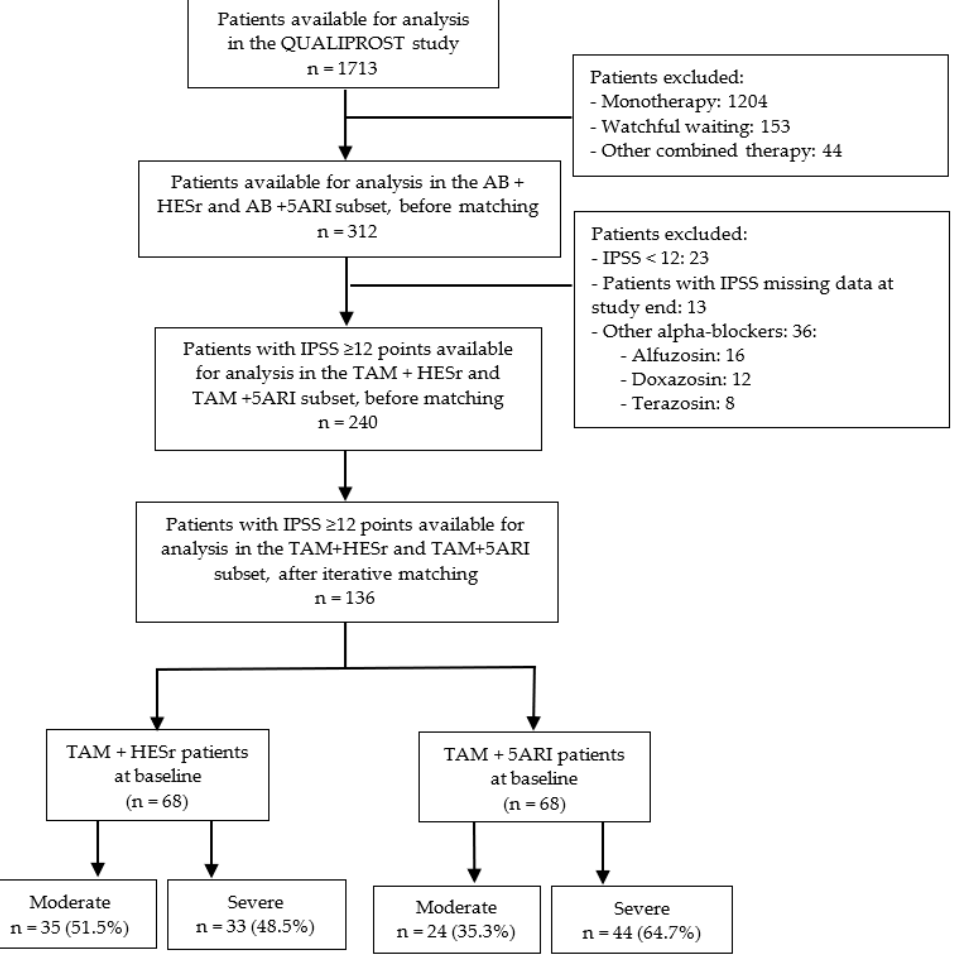
Figure 1. Study flow-chart (iterative matching sample). AB: alpha-blockers; TAM: tamsulosin; 5ARI; 5-alpha-reductase inhibitor; HESr: hexanic extract of Serenoa repens ; IPSS: International Prostate Symptom Score. Table 1. Patient baseline characteristics by treatment group (iterative matching sample). TAM + HESr